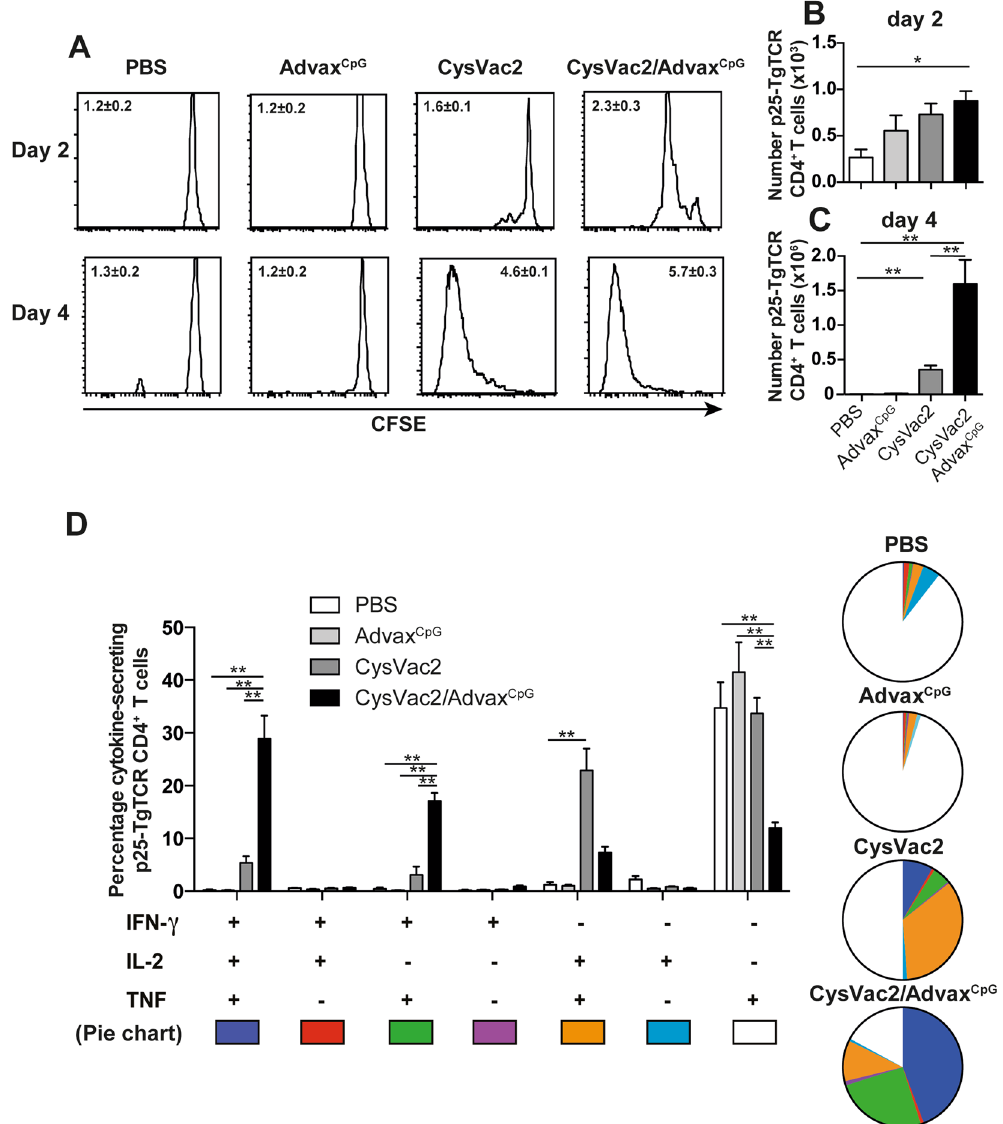
Figure 5. Advax CpG -adjuvanted vaccines induce early priming of antigen-specific CD4 + T cells. Five × 10 5 CFSE-labelled p25-TgTCR splenocytes (CD45.1 + ) were i.v. transferred into C57BL/6 mice (CD45.2 + ) (n = 4). The next day mice were injected i.d. in each ear with PBS, Advax CpG , CysVac2 protein alone, or CysVac2/ Advax CpG . p25-TgTCR CD4 + T cells CFSE dilution profiles and proliferation index ( ± SEM) were calculated ( A ). Total cell numbers were evaluated by flow cytometry at day 2 ( B ) or day 4 ( C ) in the auricular lymph node (aLN). Cells isolated from the aLN were re-stimulated over night in the presence of Ag85B 240–254 /brefeldin A and the frequency of p25-TgTCR CD4 + T cells producing IFN- γ , IL-2 or TNF was determined by intracellular staining and flow cytometry ( D ). Data (average ± SEM) is representative of two independent experiments. Statistical significance between groups was determined by ANOVA ( ** p <